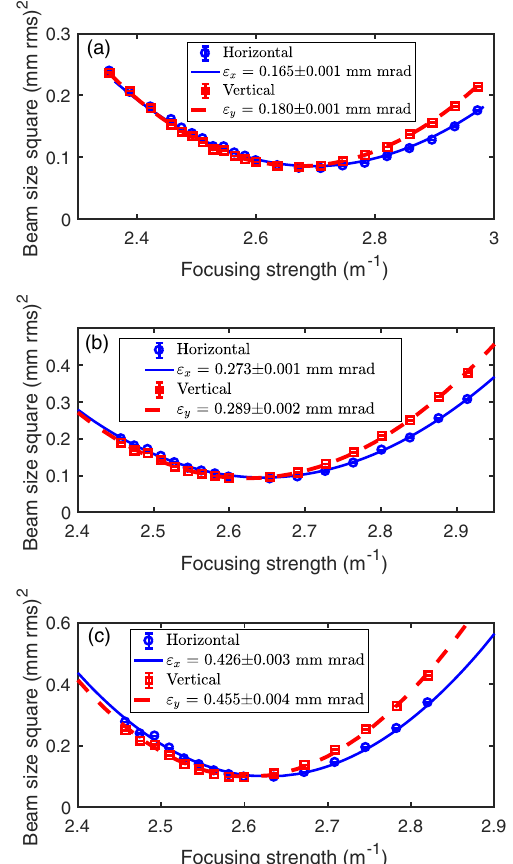
FIG. 13. The measurement results of solenoid scans. (a), (b) and (c) correspond to three laser diameters of 0.6 mm, 1 mm and 1.5 mm respectively. Horizontal axis is the integrated focusing strength of the gun solenoid.